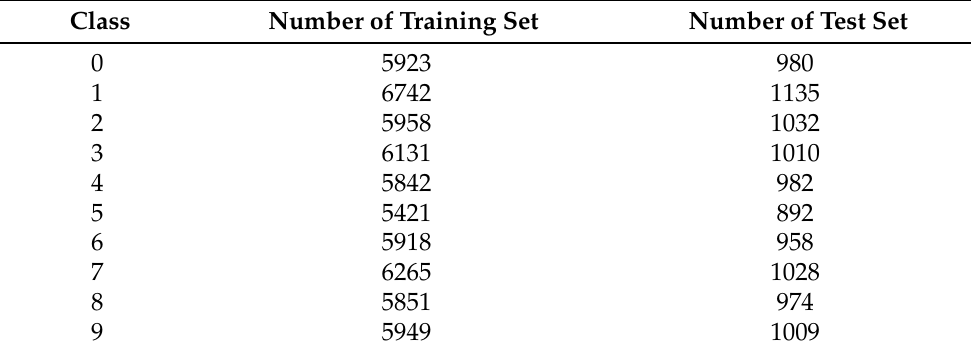
Table 1. Training and test sample numbers of the Mnist dataset.